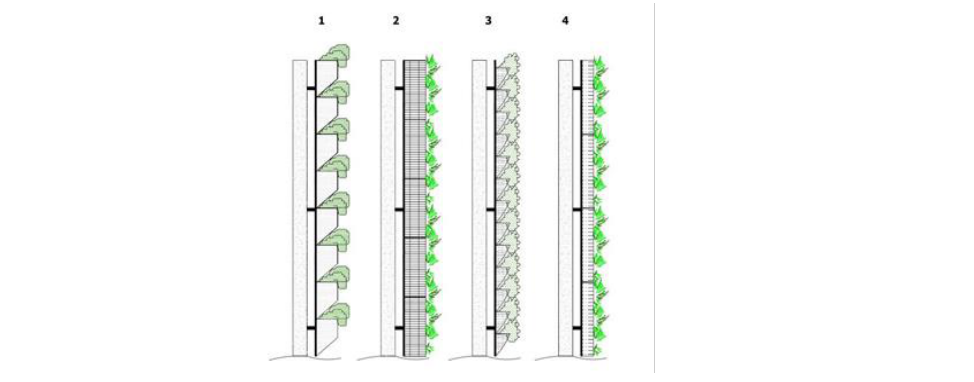
Figure 2 Green facade types (Ottele,